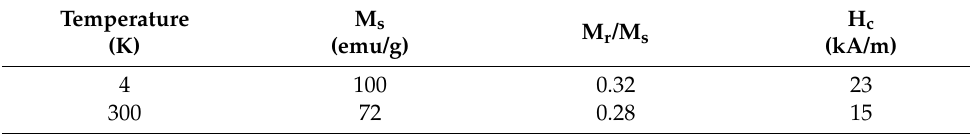
Table 1. Magnetic parameters of the Zn ferrites obtained from DC magnetometry *.